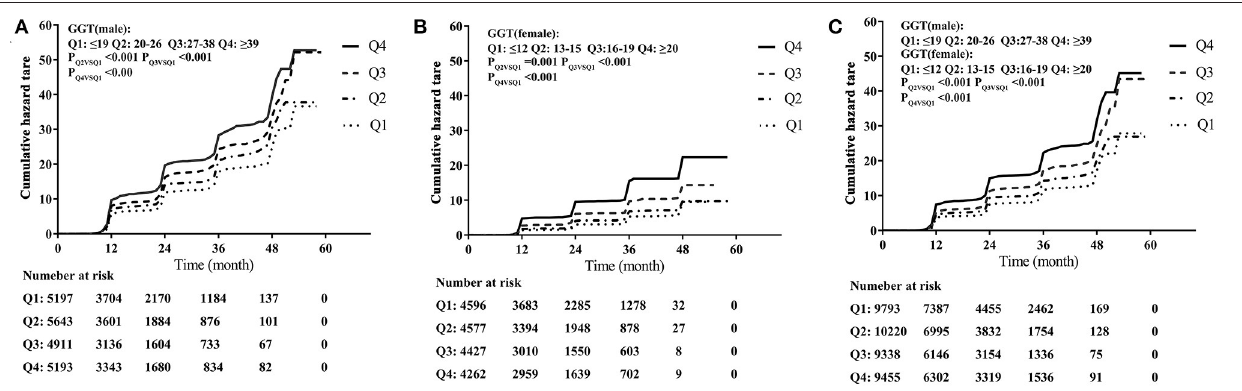
adults without metabolic syndrome and (2) demonstrating that the association between serum GGT level and incidence of hypertension may be determined for both males and females through sex-specific multivariate regression